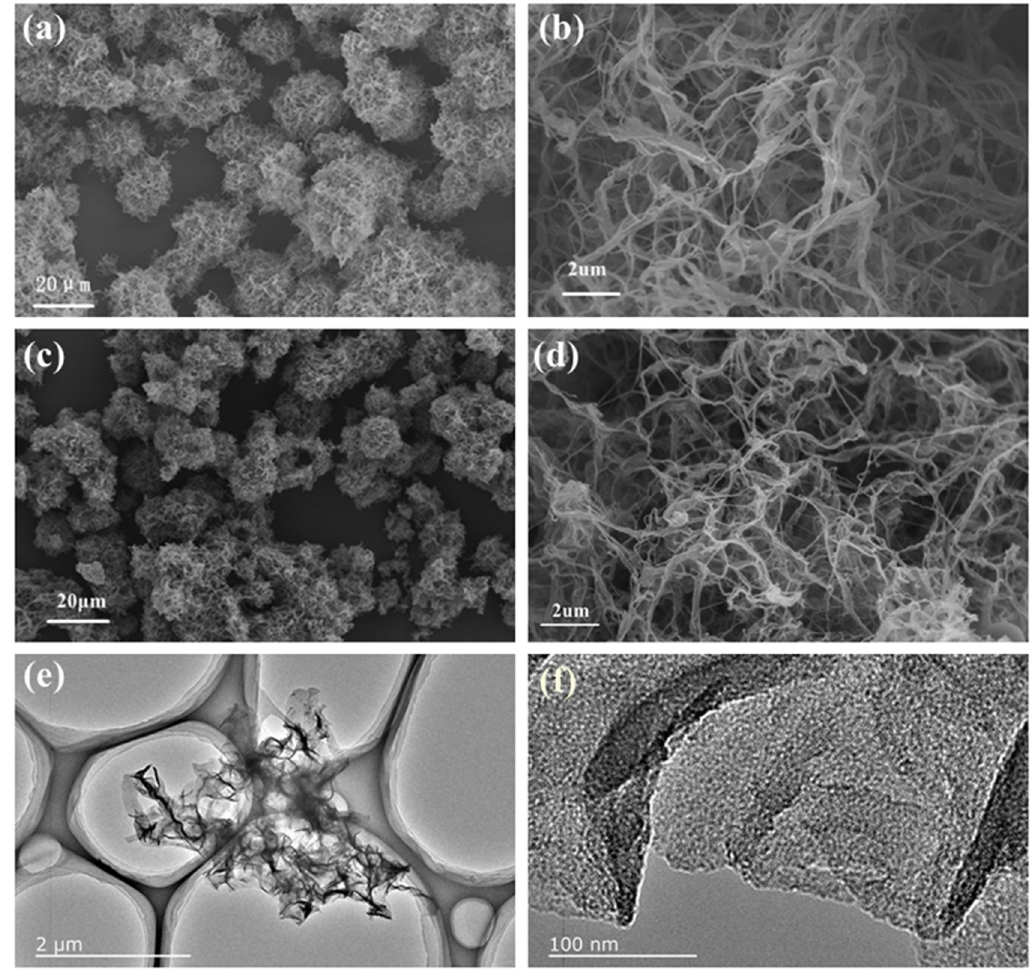
Figure 2. ( a , b ) Scanning electron microscope (SEM) images of LPHF precursor; ( c , d ) SEM images of NCNBs-45; ( e , f ) Transmission electron microscopy (TEM) images of NCNBs-45.